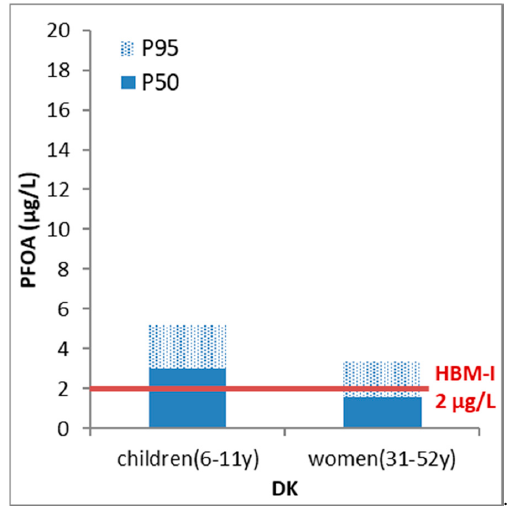
Figure 3. Benchmarking HBM results for perfluorooctanoic acid (PFOA) in women and children (50th and 95th percentile) (DEMOCOPHES) against the German HBM-I guidance value. At concentrations below the HBM-I value no adverse health effects are expected according to current knowledge.